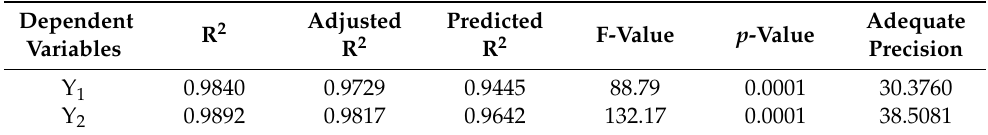
Table 3. Regression analysis results for Y 1 and Y 2